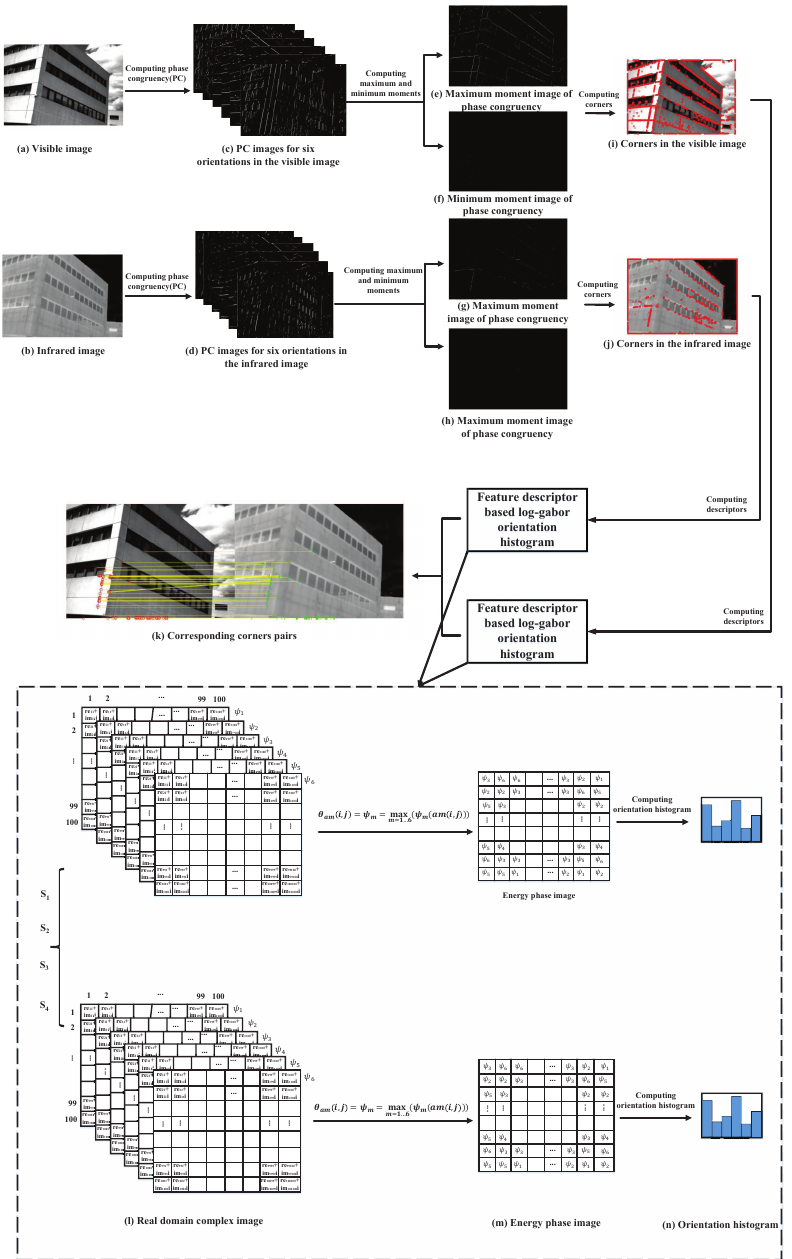
Figure 1. Overview of feature point matching based on phase congruency and log-Gabor filters for infrared and visible images: ( a , b ) show the target image and the reference image; ( c , d ) show phase congruency (PC) images for six orientations in the visible and infrared images; ( e – h ) show maximum and minimum moments of the phase congruency for the visible and infrared images; ( i , j ) show the corners in the visible and infrared images; ( k ) shows the corresponding pairs; ( l ) shows the complex images in the real domain obtained with log-Gabor filters; ( m ) shows the phase image with maximum energy; and ( n ) shows the orientation histograms of the phase